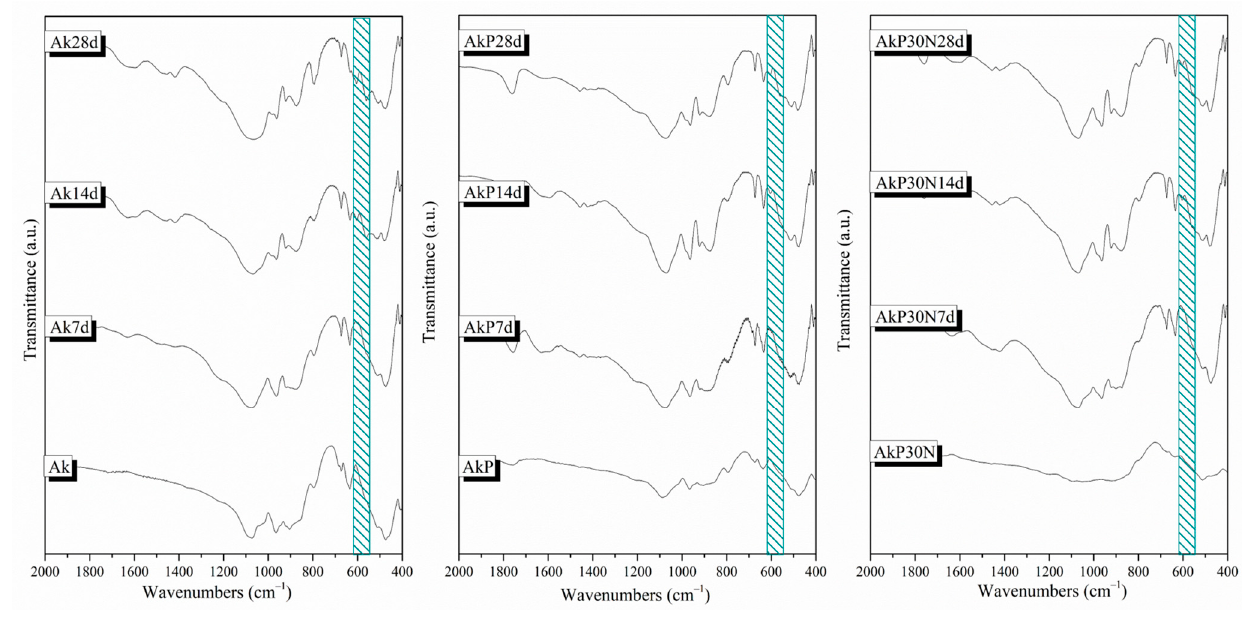
Figure 19. FTIR spectra of synthesized scaffolds after 1, 2, and 4 weeks of immersion in SBF. The shadow area between 560 and 640 cm -1 highlights the double peak attributed to the formation of an apatite layer on the surface of all samples.